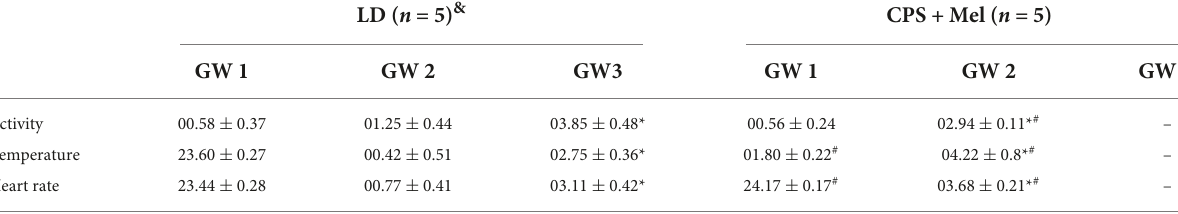
TABLE 2 Effect of CPS + Mel on the acrophase (clock time hours) of maternal circadian rhythms measured telemetrically (Mean ±